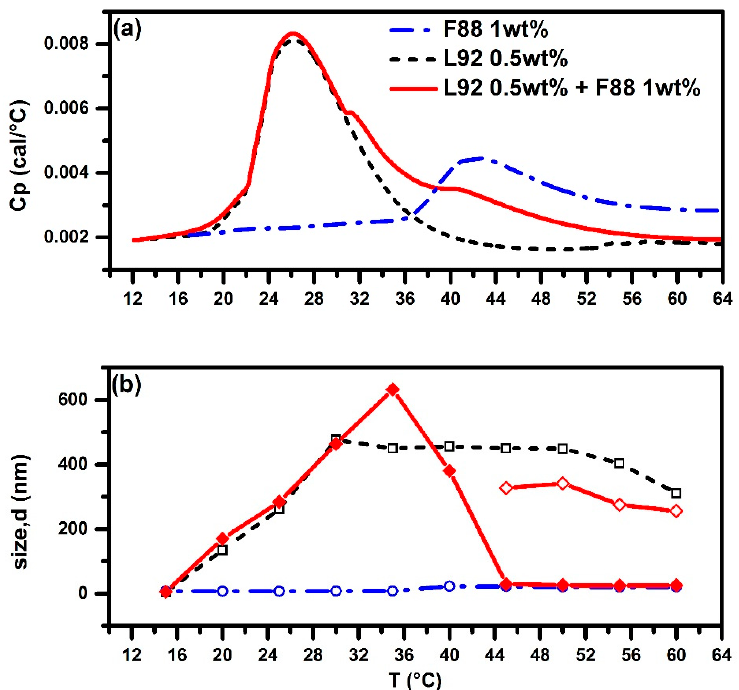
Figure 4. HSDSC thermograms ( a ) and evolution of size of aggregates ( b ) as a function of temperature from DLS for pure 0.5 wt % L92, pure 1 wt % F88, and mixed Pluronic 0.5 wt % L92 + 1 wt % F88 systems. Red solid line and diamond ( ◆ ) for L92 + F88. Red solid line and open diamond ( ◇ ) for L92 + F88 (the other coexisting aggregates). Black dashed line and open square ( □ ) for pure L92. Blue dashed-dotted line and open circle ( ○ ) for pure F88.